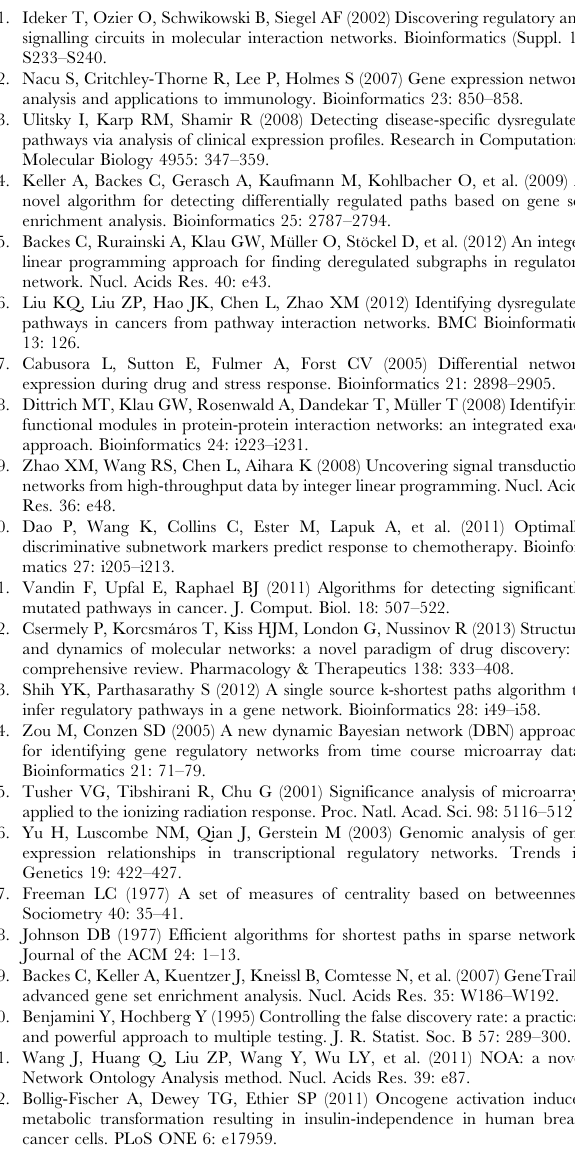
Table S1 All the significantly enriched KEGG pathways with respect to the integrated deregulated module. The table lists the results of ORA on the integrated deregulated module. All the enriched KEGG pathways which include at least five genes of the integrated deregulated module are presented. And their signifi- cance p-values are calculated using the FDR adjustment method. Table S2 All the significantly enriched KEGG pathways with respect to the SNAI1 associated deregulated module. The table lists the results of ORA on the SNAI1 associated deregulated module. The significance p-values are calculated using the FDR adjustment method.